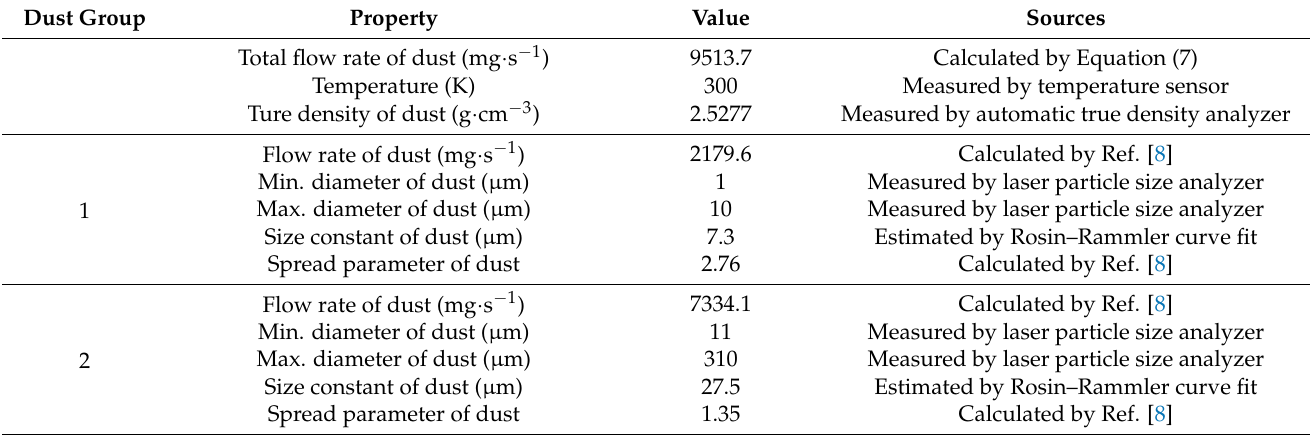
Table 2. Discrete phase parameters used in the